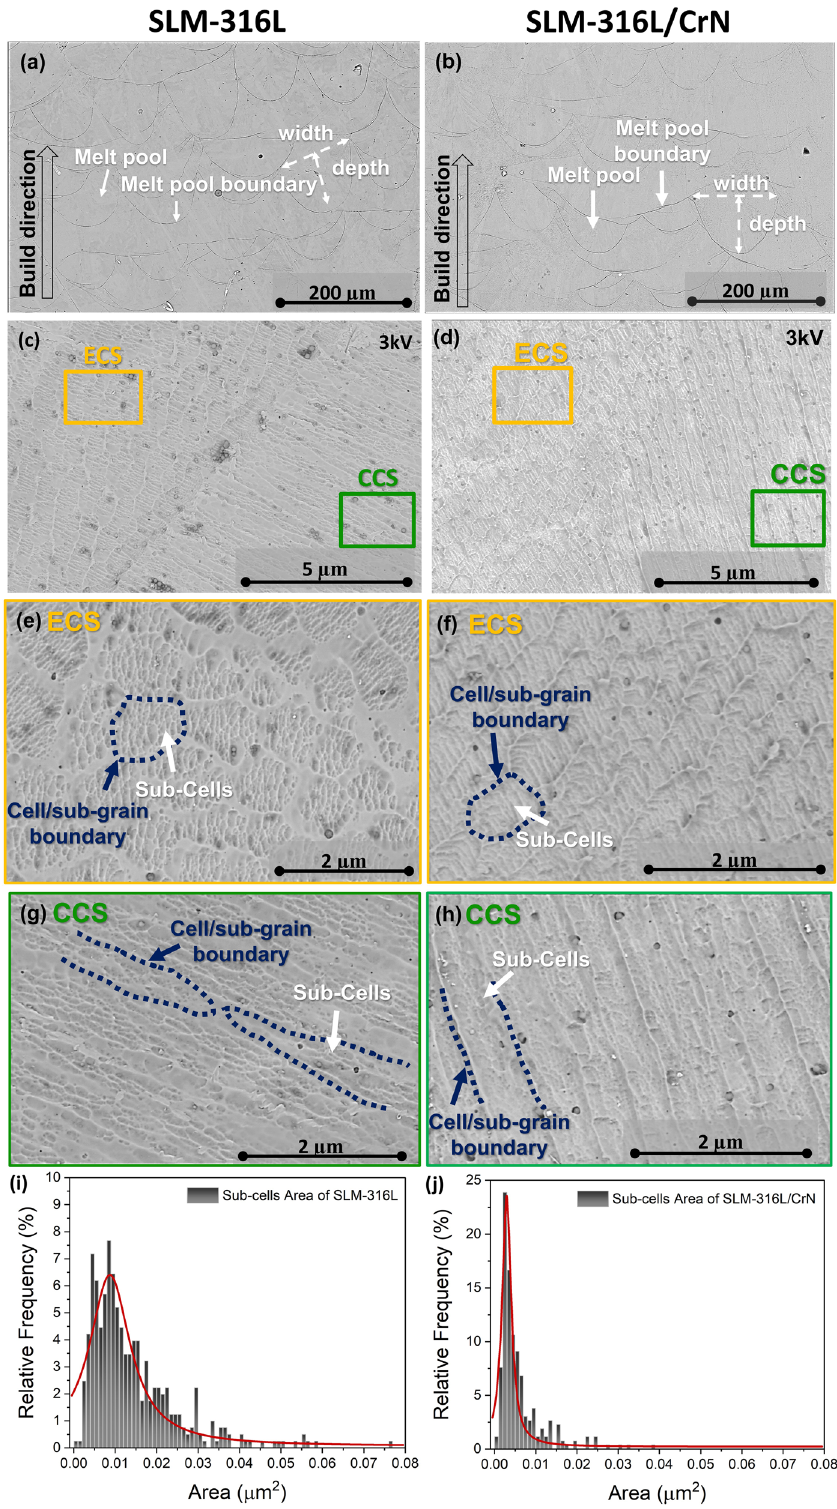
Fig. 1 SEM-BSE images at different magni fi cations showing the microstructure of etched SLM-316L and SLM-316L/CrN. a , b Cross- sectional view; c , d CCS – Columnar cellular structure and ECS – Equiaxed cellular structure; e – h ECS and CCS revealing the cells, cell boundaries, sub-cells, and sub-cell boundaries; i , j Histogram representing the area distribution of sub-cells.